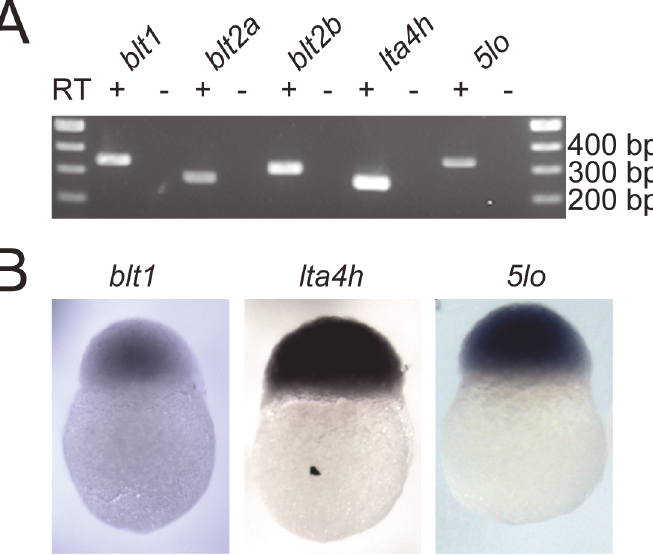
Fig 9. Expression of blt1 , blt2a , blt2b , lta4h , and 5lo in zebrafish embryos. (A) Expression of blt1 , blt2a , blt2b , lta4h , and 5lo mRNA were analyzed by RT-PCR. Total RNA was obtained from 24 hpf embryos and analyzed using specific primers for blt1 , blt2a , blt2b , lta4h , and z5lo . (B) Expression of blt1 , lta4h , and 5lo mRNA was analyzed by whole-mount in situ hybridization. Zebrafish embryos (3 hpf) were hybridized with antisense